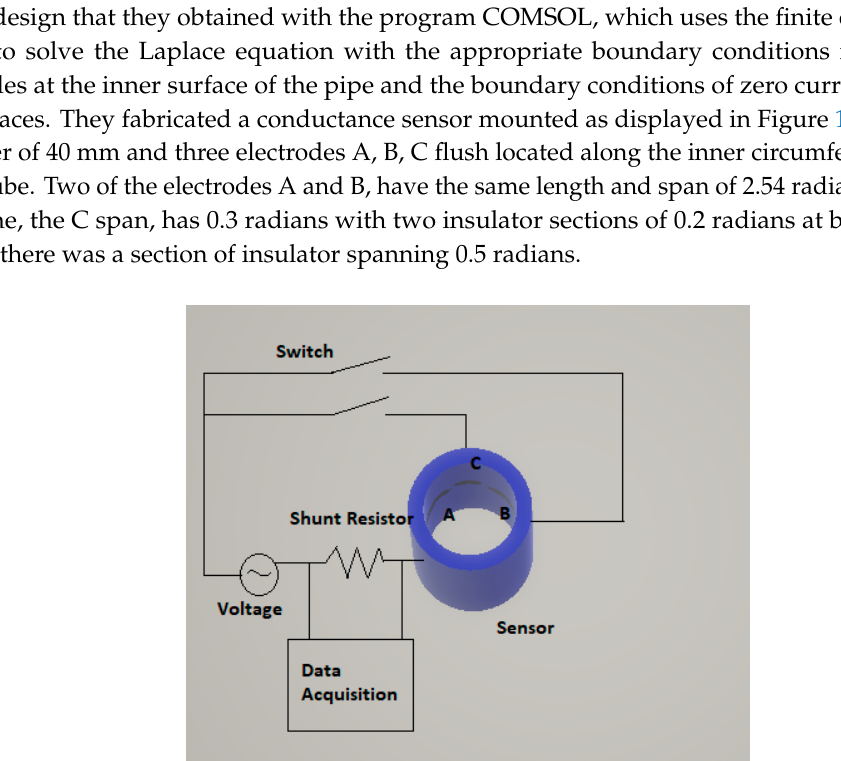
Figure 9. G/Gmax versus δ computed with Coney formula valid for (cid:1864) ≫ (cid:1853) with the characteristics